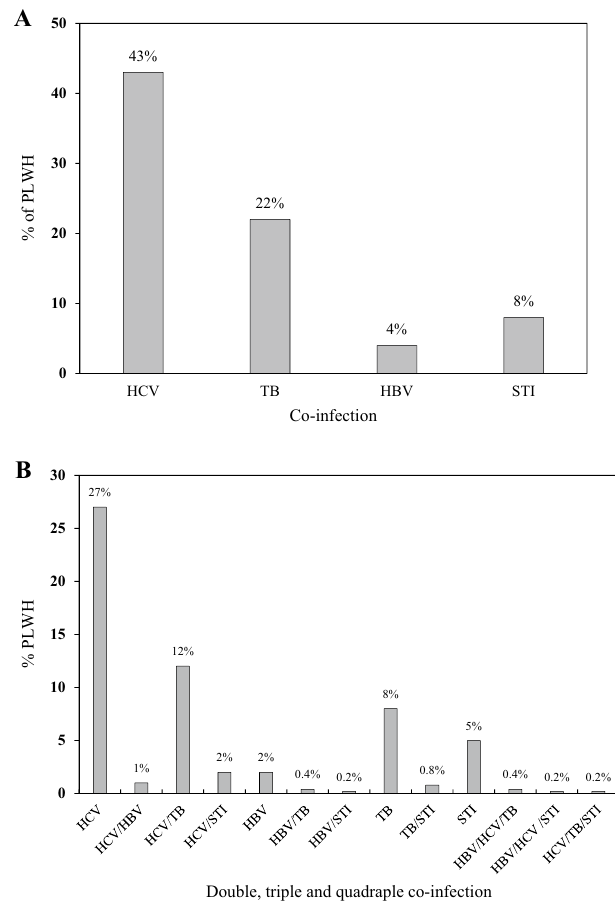
Figure 2. Co-infection: ( A ) Overall co-infection rates and ( B ) double, triple and quadruple infections. ( A ) Occurrence of HCV, TB, HBV, and STI among PLWH study participants. ( B ) Double, triple, and quadruple infections among the study